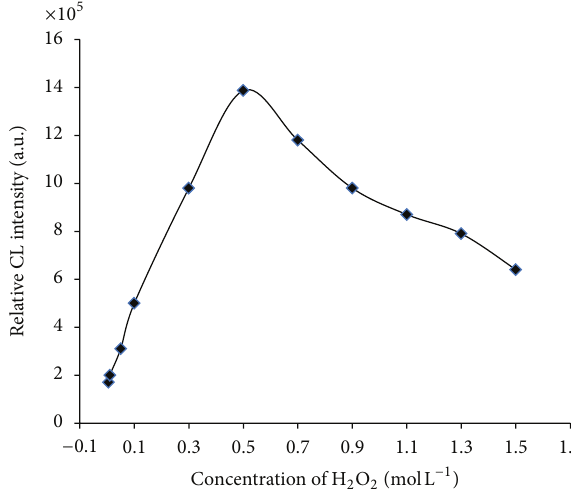
Figure 9: Effect of H 2 O 2 concentration on the CL intensity of the ionic liquid/copper-ZnS QDs-H 2 O 2 system in phosphate buffer (0.1M, pH 8.0); ZnS QDs, 20 mg L −1 .